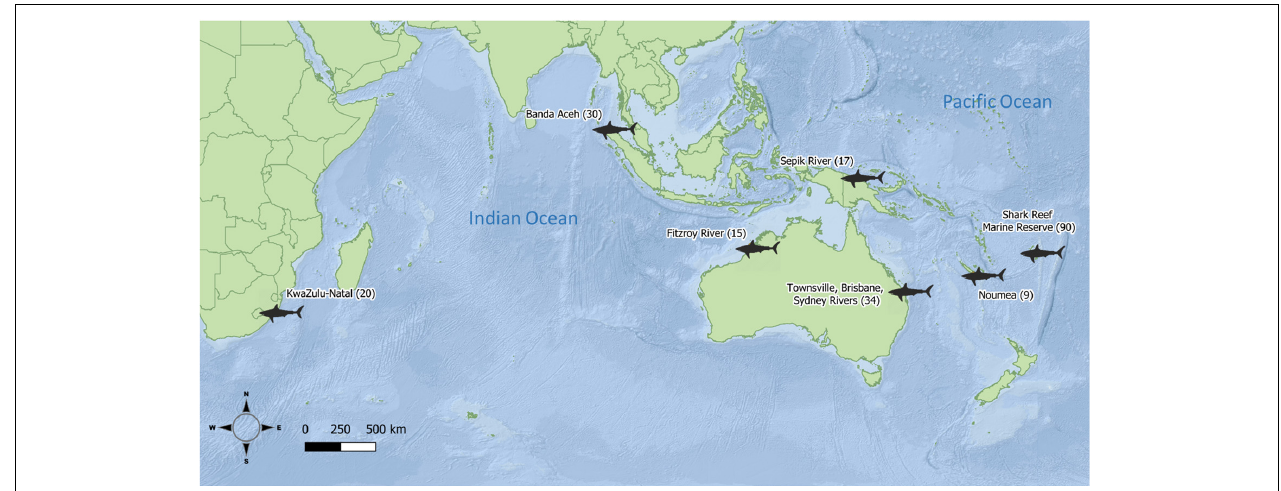
FIGURE 1 | Locations of sample sites with numbers of samples in